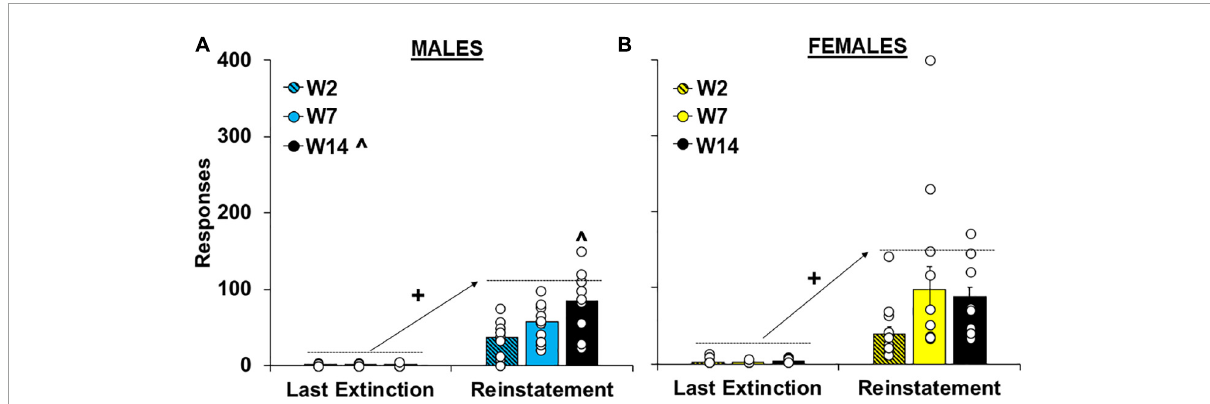
FIGURE4 Sex- and withdrawal-specific changes in cue-induced reinstatement responding. Mean ( ± SEM) number of responses made on the lever formerly associated with cocaine during the last extinction session versus the reinstatement session for (A) males and (B) females the early (W2; n = 13 females, 10 males), intermediate (W7; n = 13 females, 10 males), and late (W14; n = 13 females, 10 males) withdrawal groups. White circles indicate individual data points. + Significant increase from the last extinction session. ˆSignificantly higher than the early withdrawal group.